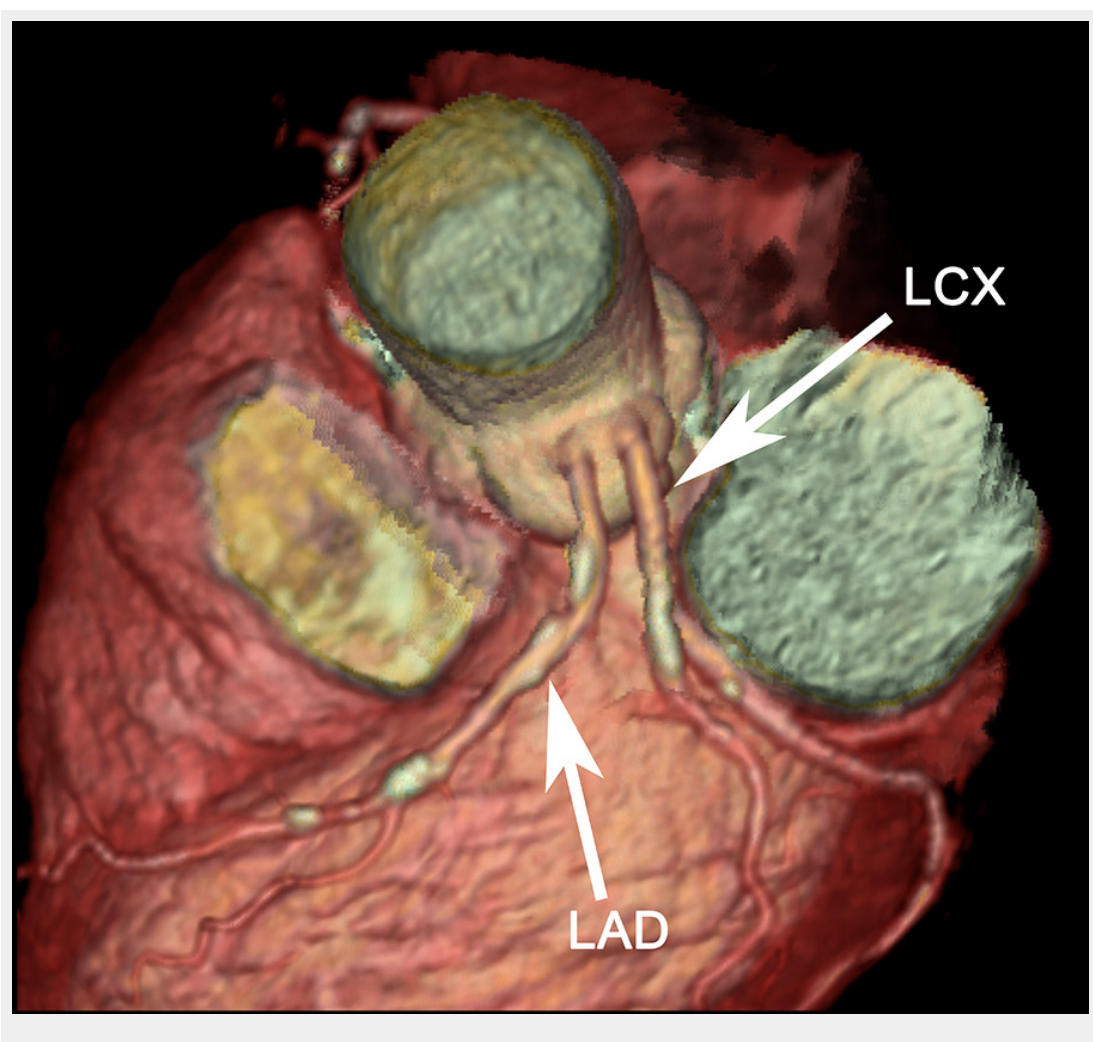
Figure 5 CCTA of a 63-year-old male shows obstructive CAD and absent left main stem with separate ostium for LAD and LCX. Absent left main stem is considered a benign variant of CAA, but the finding may be of clinical importance for eventual revascularisation procedures. CAA = coronary artery anomaly; CAD = coronary artery disease; CCTA = coronary computed tomography angiography; LAD = left anterior descending artery; LCX = left circumflex coronary